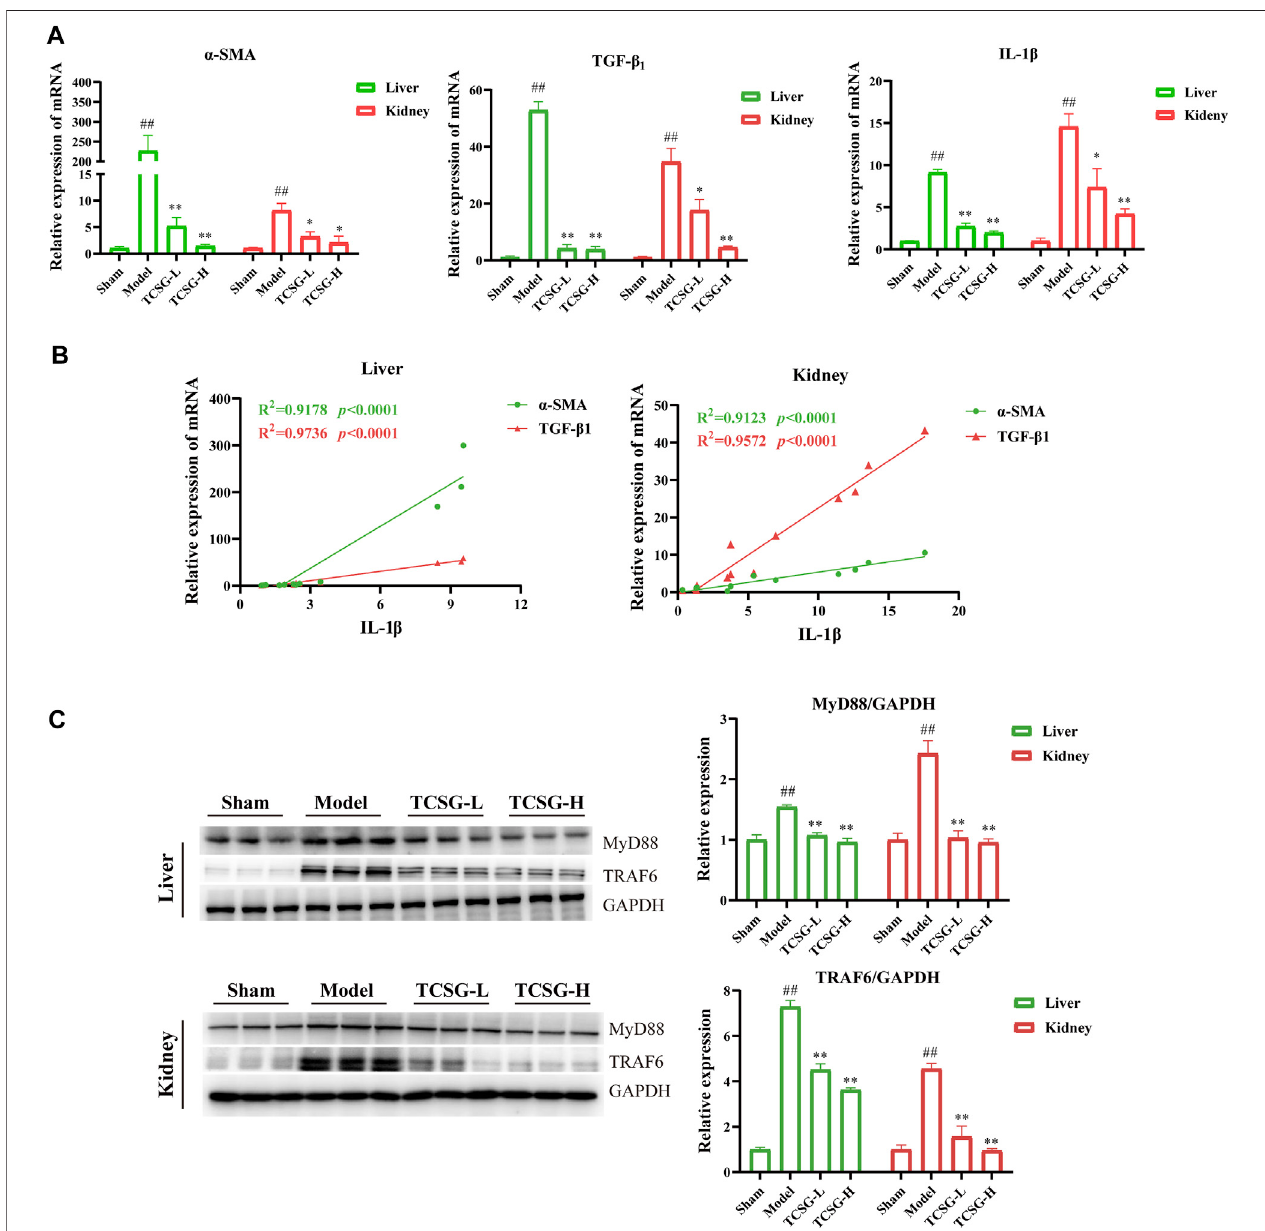
FIGURE 5 | TCSG from Baishouwu ameliorated hepatic and renal fi brosis by suppressing IL-1 β /MyD88 in fl ammation signaling. (A) mRNA expressions of α -SMA, TGF- β 1,andIL-1 β intheliverandkidney. (B) CorrelationofIL-1 β levelswith α -SMAandTGF- β 1levelsintheliverandkidney.R (cid:1) Spearman ’ srankcorrelationcoef fi cient. (C) Western blot and quantitative analysis of MyD88 and TRAF6 expression in the liver and kidney. Data are shown as means ± SEM ( n (cid:1) 3), ## p < 0.01, signi fi cantly different from sham group; * p < 0.05, ** p < 0.01, signi fi cantly different from model group.